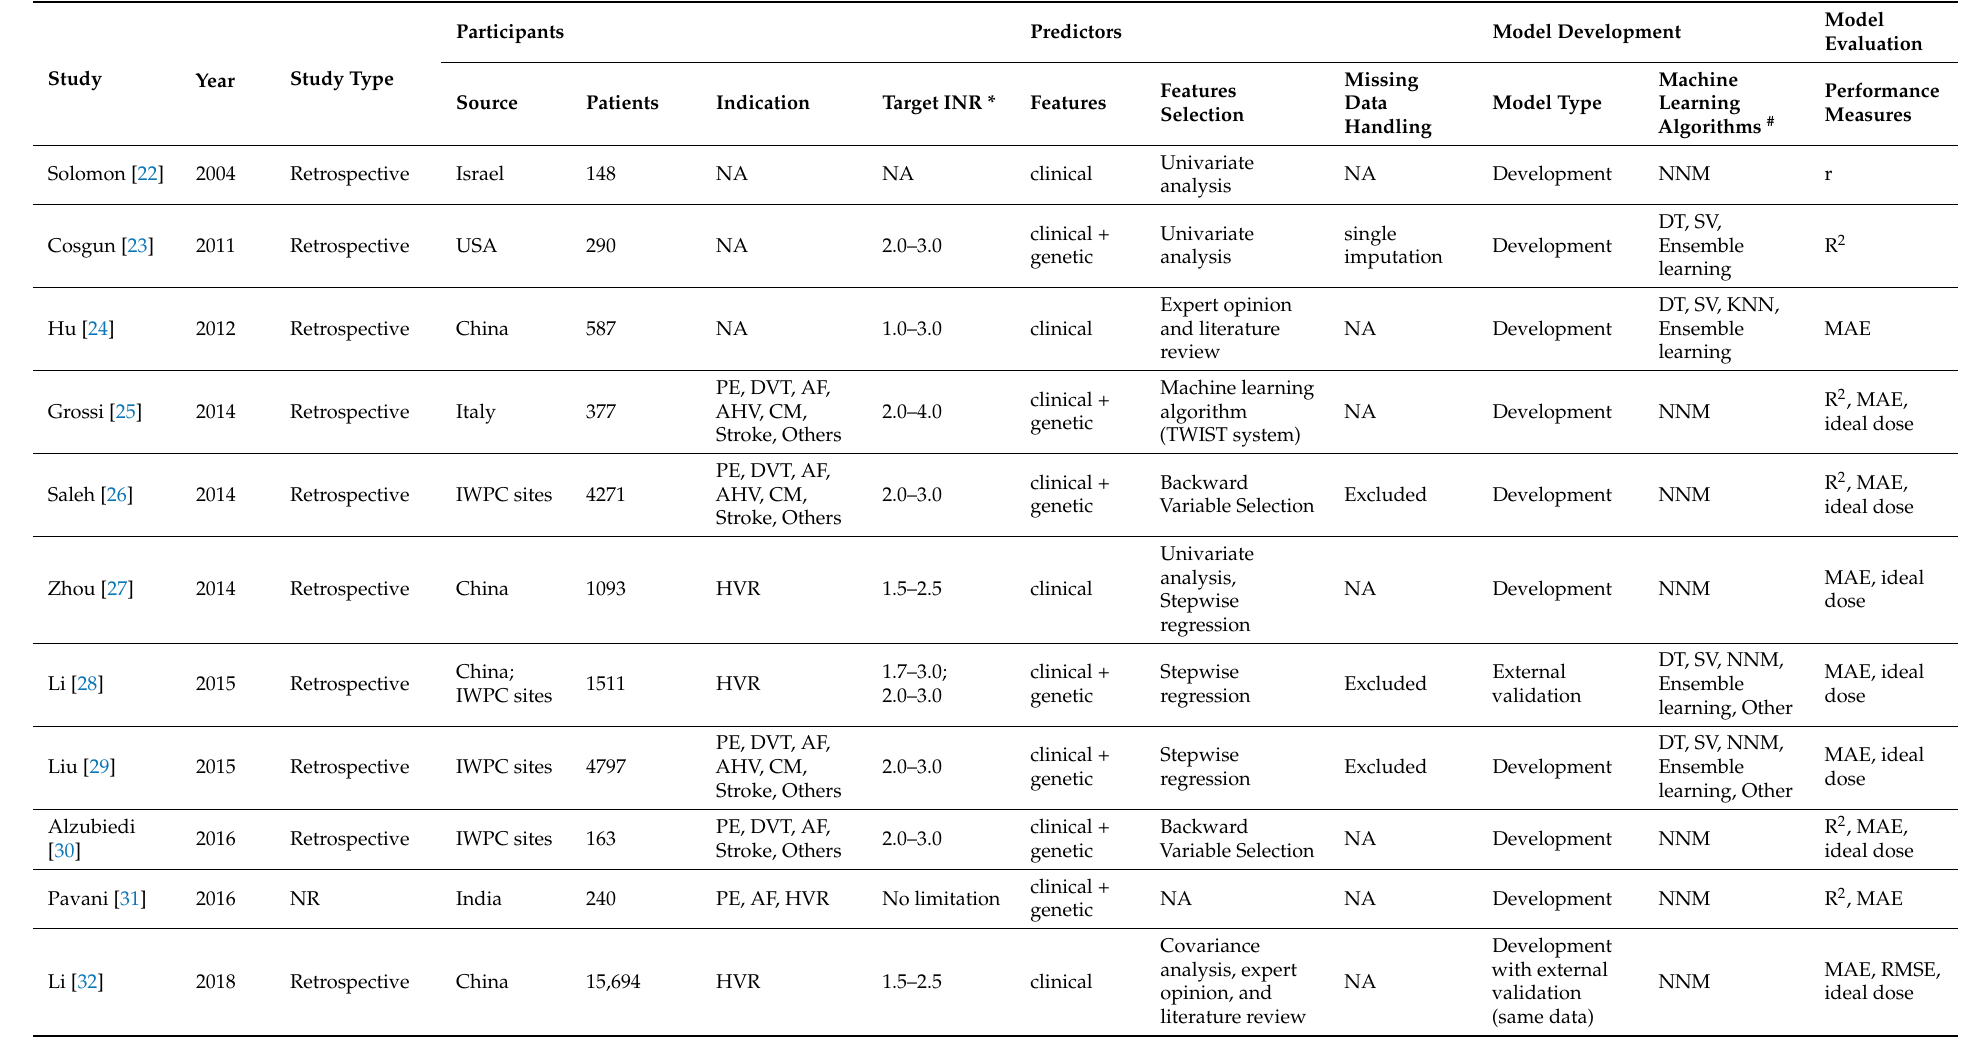
Table 1. Summary characteristics of